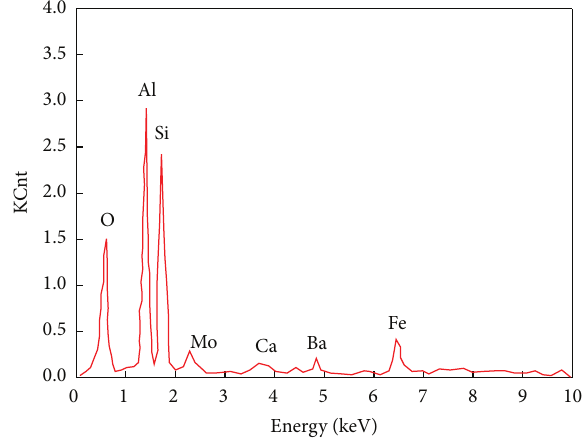
Figure 8: The image of EDX measured results.